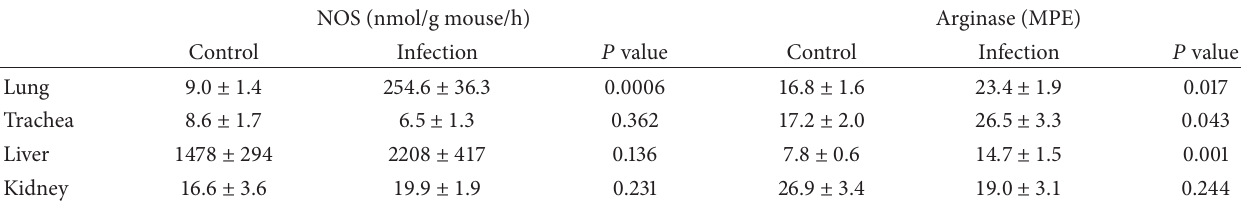
Table 2: Tissue L-arginine metabolizing enzyme activities after stable isotope infusion in vivo